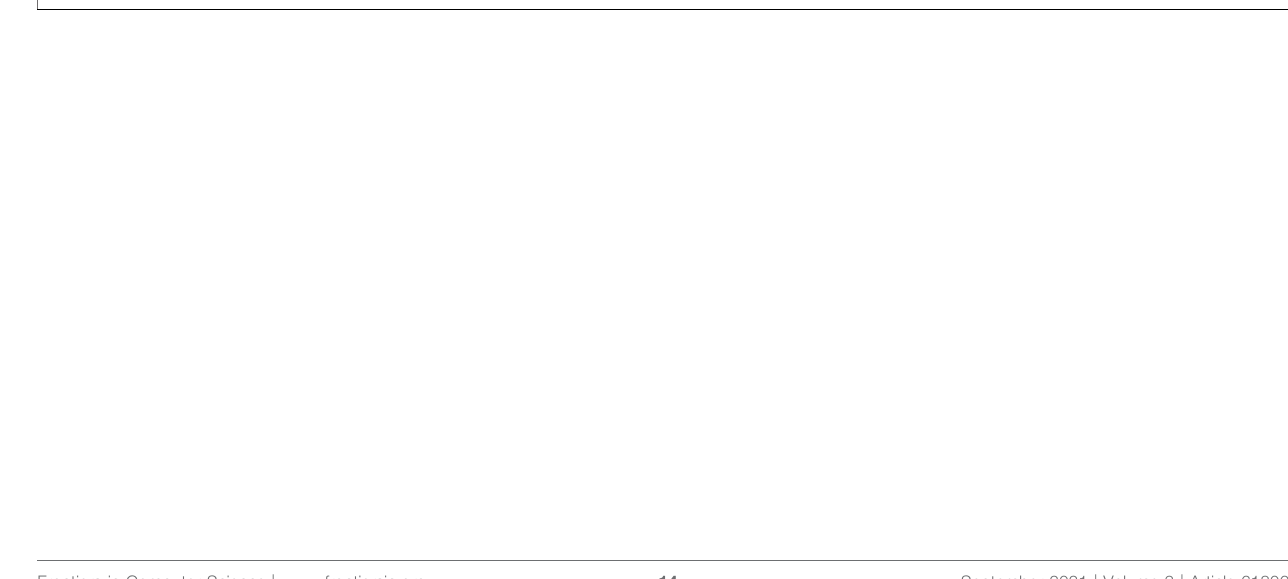
Frontiers in Computer Science |